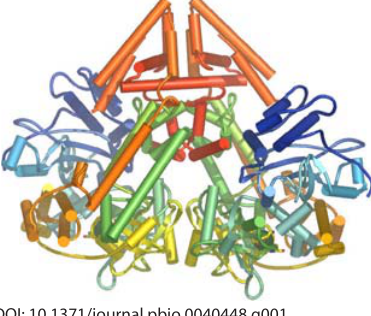
Schematic showing the fold of the QDE-1 RNA interference polymerase. The dimeric molecule is shown with the polypeptide chains colored from blue at the N termini to red at the C